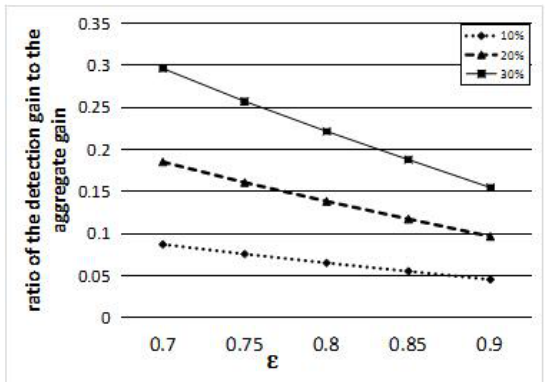
Figure 5. The ratio of the detection gain to the aggregate gain with different thresholds (cid:101)